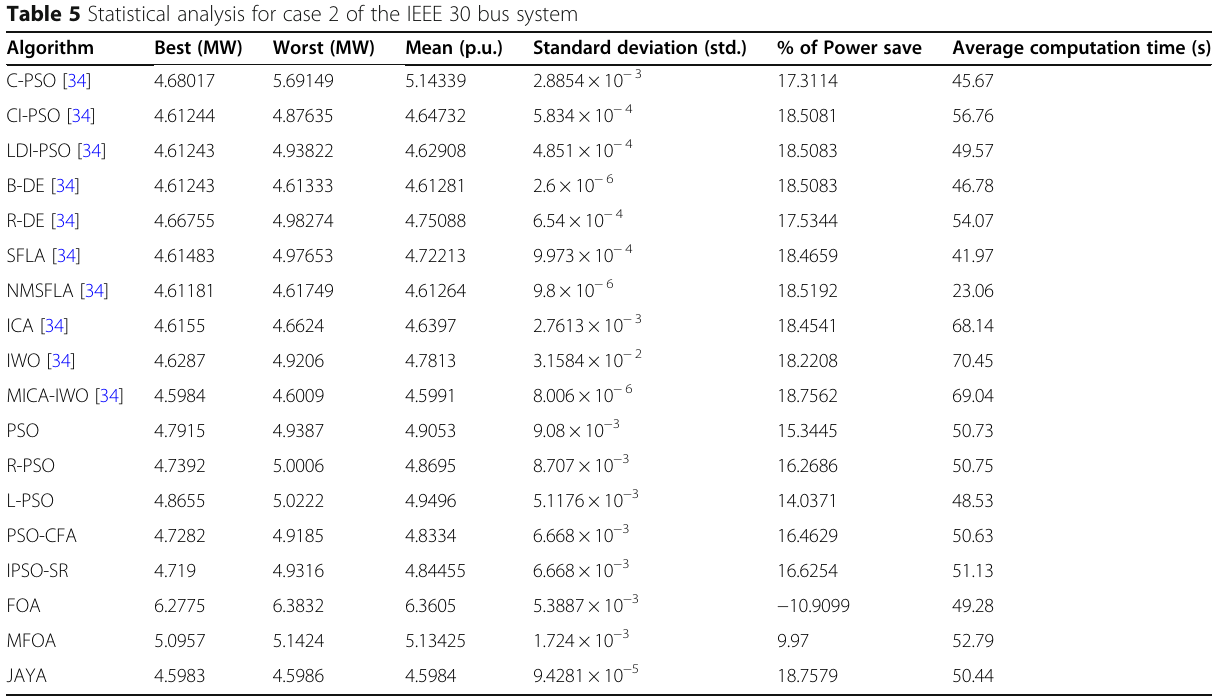
Table 5 Statistical analysis for case 2 of the IEEE 30 bus system